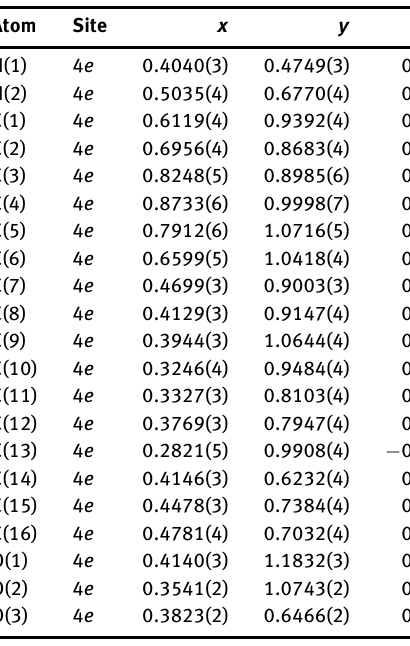
Table 3: Fractional coordinates and atomic displacement parameters (Å 2